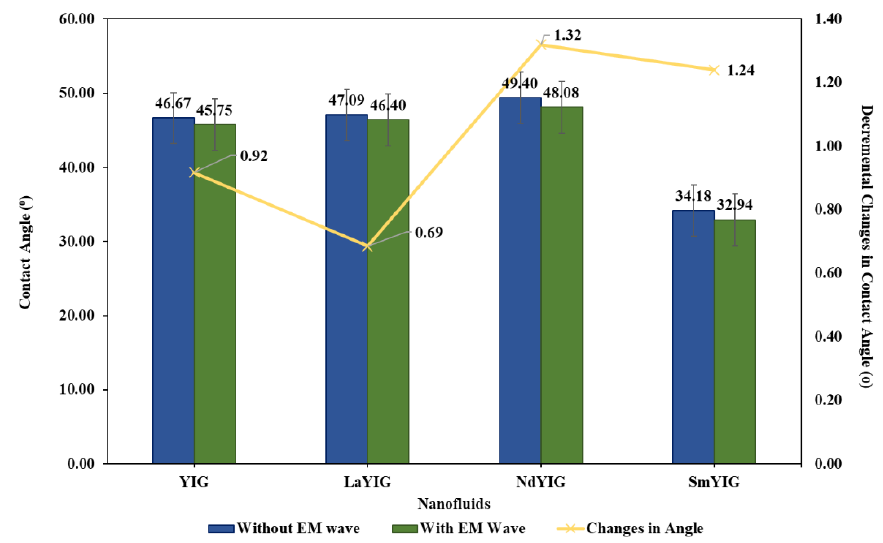
Figure 5. Contact angle for RE-YIG samples with and without EM waves.